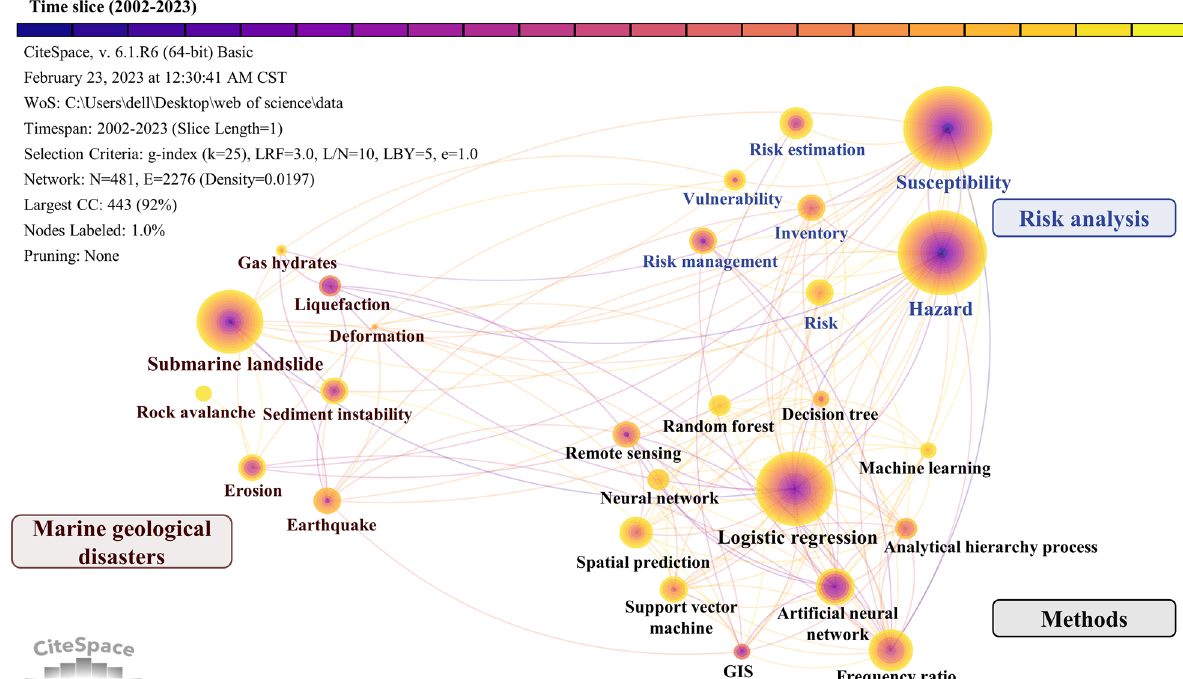
Fig. 2 Co-occurrence analysis of keywords on the risk analysis of marine geological disasters from 2002 to 2023. The circles are the nodes of keywords, the size of a circle represents the frequency of the word, the change in color from the center to the outer edge represents the change in word frequency over time (data from Web of Science ™ ); where the retrieval strategy consisted of searching for the topics “susceptibility*” or “hazard*” or “risk*” AND “assessment*” or “evaluation*” AND “marine” or “submarine” or “ocean” or “sea*” AND “geolog*” or “geotechni*”, and the asterisk (*) represents any group of characters, including no